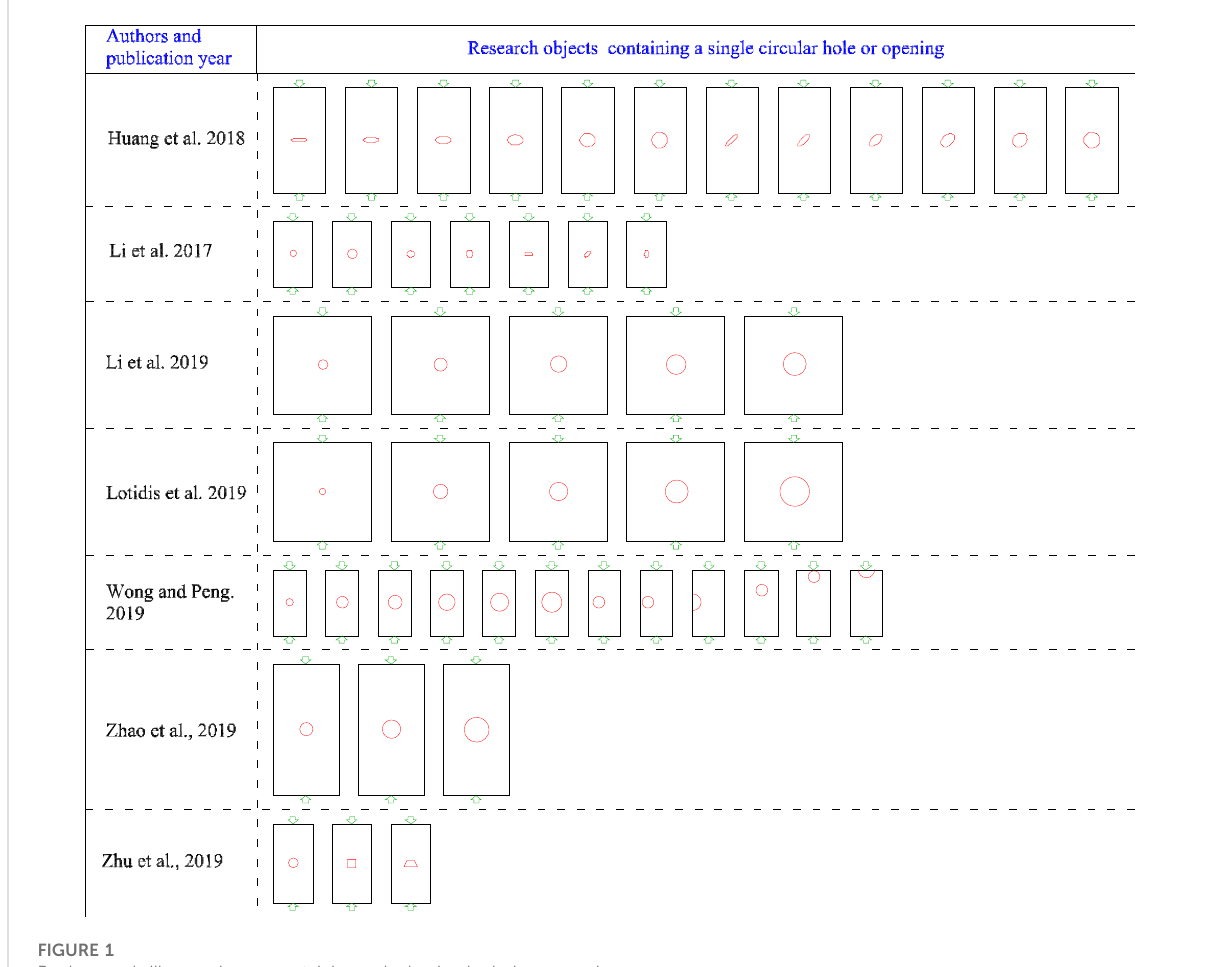
FIGURE 1 Rock or rock-like specimens containing a single circular hole or